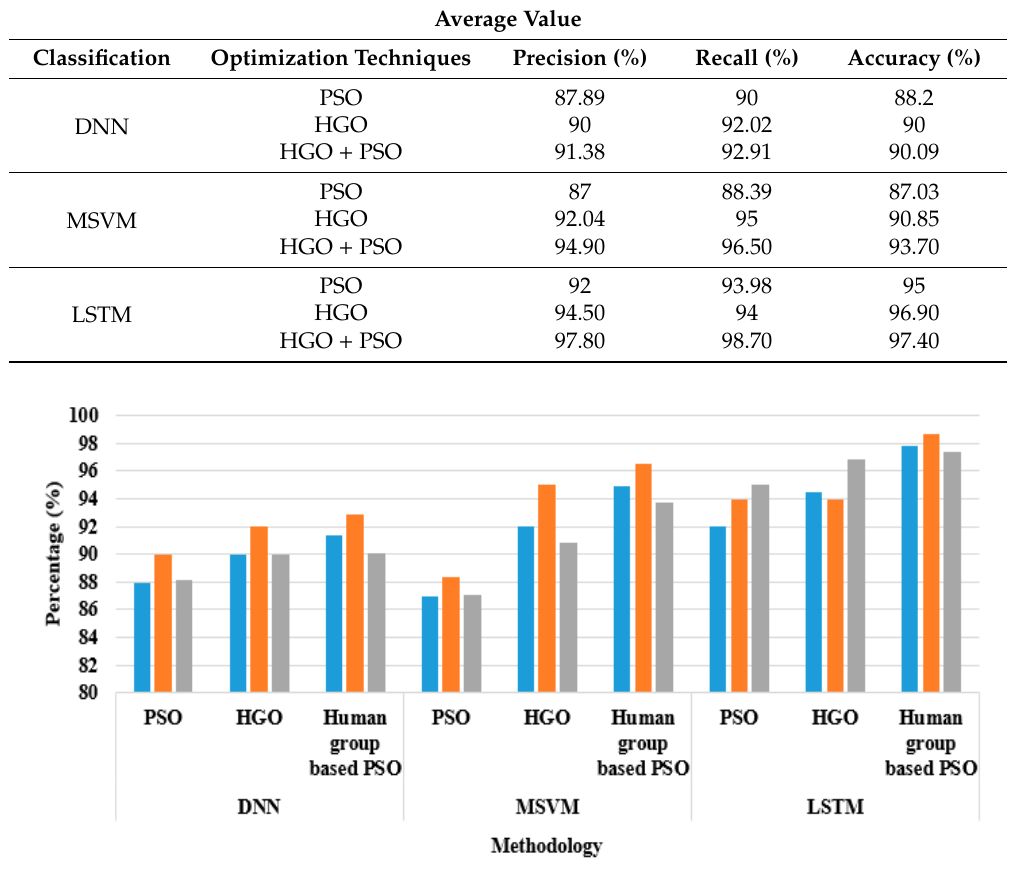
Table 14. Performance investigation of the proposed model on Eurosat dataset.